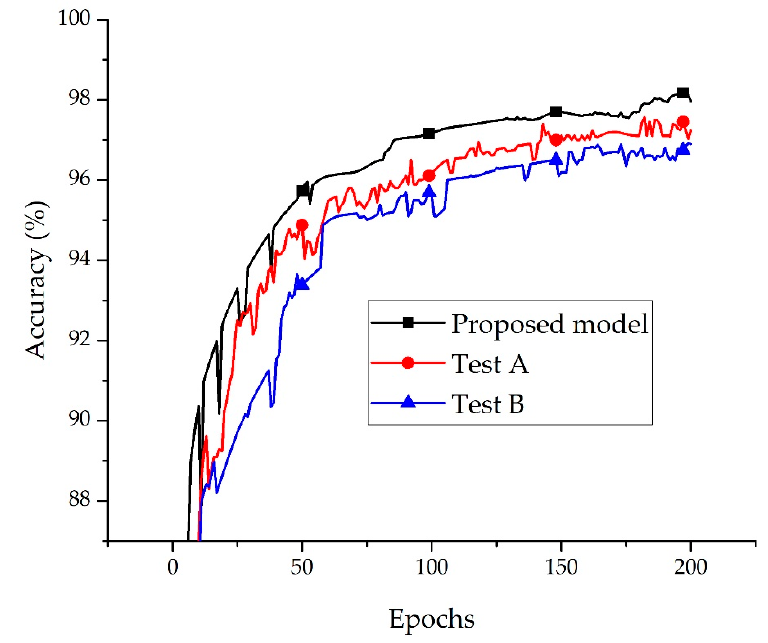
Figure 11. Validation accuracy curves for three models with different depths. The two models Test A and Test B are described in Figure 10 and its caption.